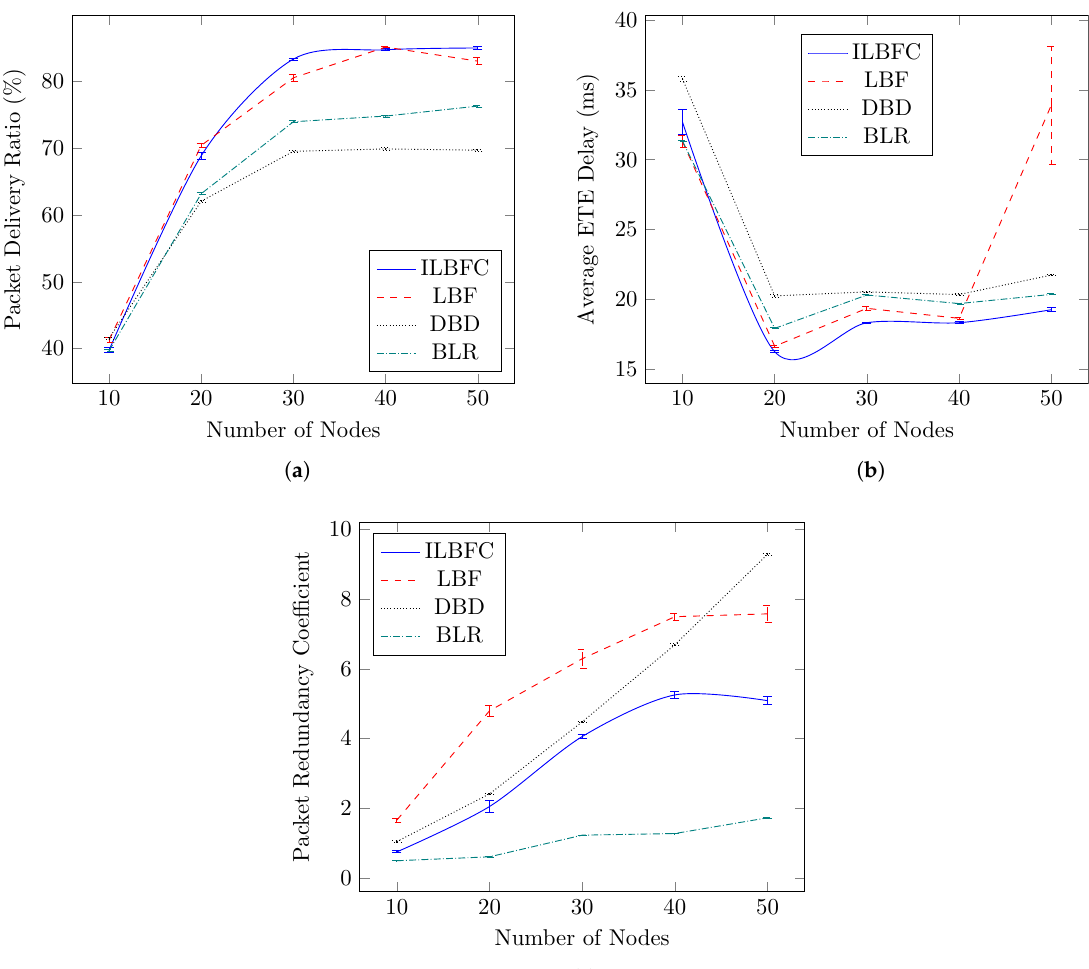
Figure 6. Performance comparison of ILBFC with LBF, DBD and BLR versus number of nodes, while keeping the maximum speed of the node equals 50 km/hr and the source transmission rate equals 400 kbps. ( a ) PDR versus number of nodes; ( b ) Average ETE delay versus number of nodes; ( c ) PRC versus number of